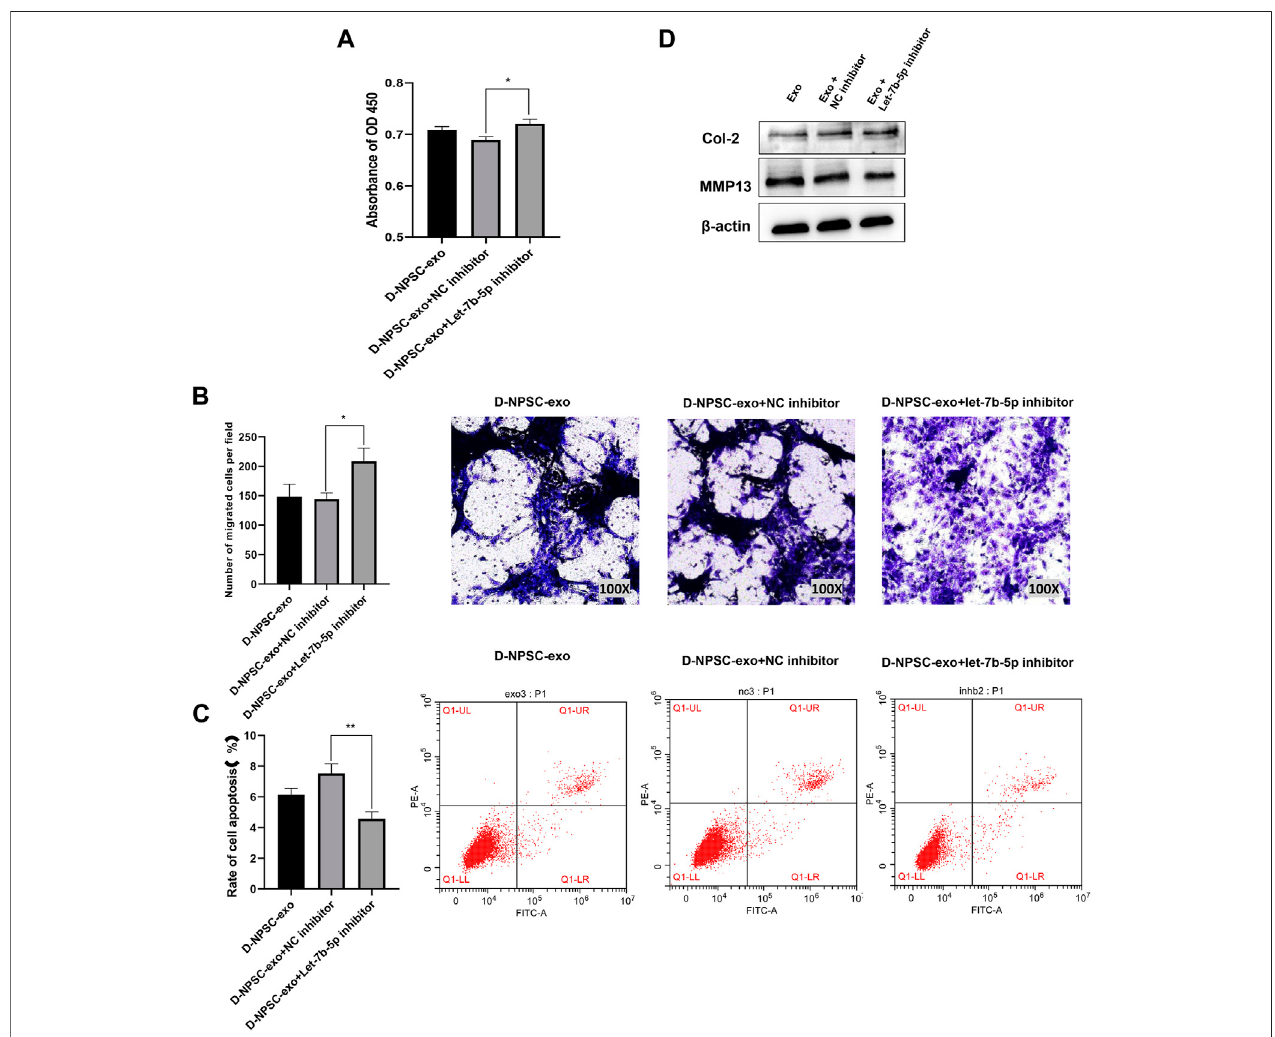
FIGURE 5 | Inhibition of let-7b-5p in D-NPSC-exo alleviated cell degeneration of AFCs. AFCs were treated with D-NPSC-exo, then transfected with let-7b-5p inhibitor or NC inhibitor. (A) Inhibition of exosomal let-7b-5p promoted cell proliferation of AFCs by CCK-8 assay. (B) Inhibition of exosomal let-7b-5p promoted cell migration of AFCs by Transwell assay. (C) Inhibition of exosomal let-7b-5p inhibited cell apoptosis of AFCs by Annexin V/PI apoptosis detection kit. (D) Inhibition of exosomal let-7b-5p inhibits the expression of MMP13 and promoted the expression of Col II by Western blotting. * p < 0.05; ** p < 0.01.